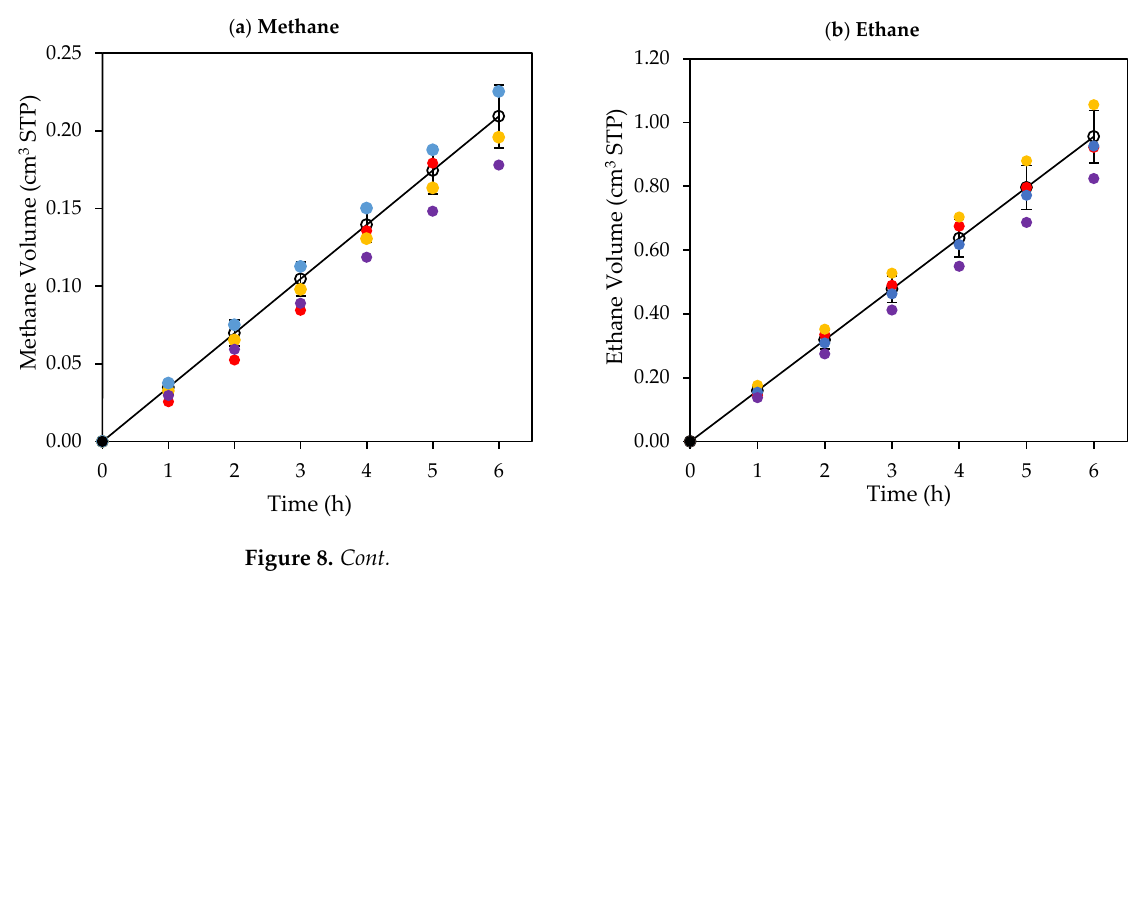
the 0.25 wt% Pd-TiO 2 photocatalyst, 0.15 g L −1 photocatalyst concentration, 2.0 v / v % etha- nol, initial pH = 4 ± 0.05 and near-UV irradiation .